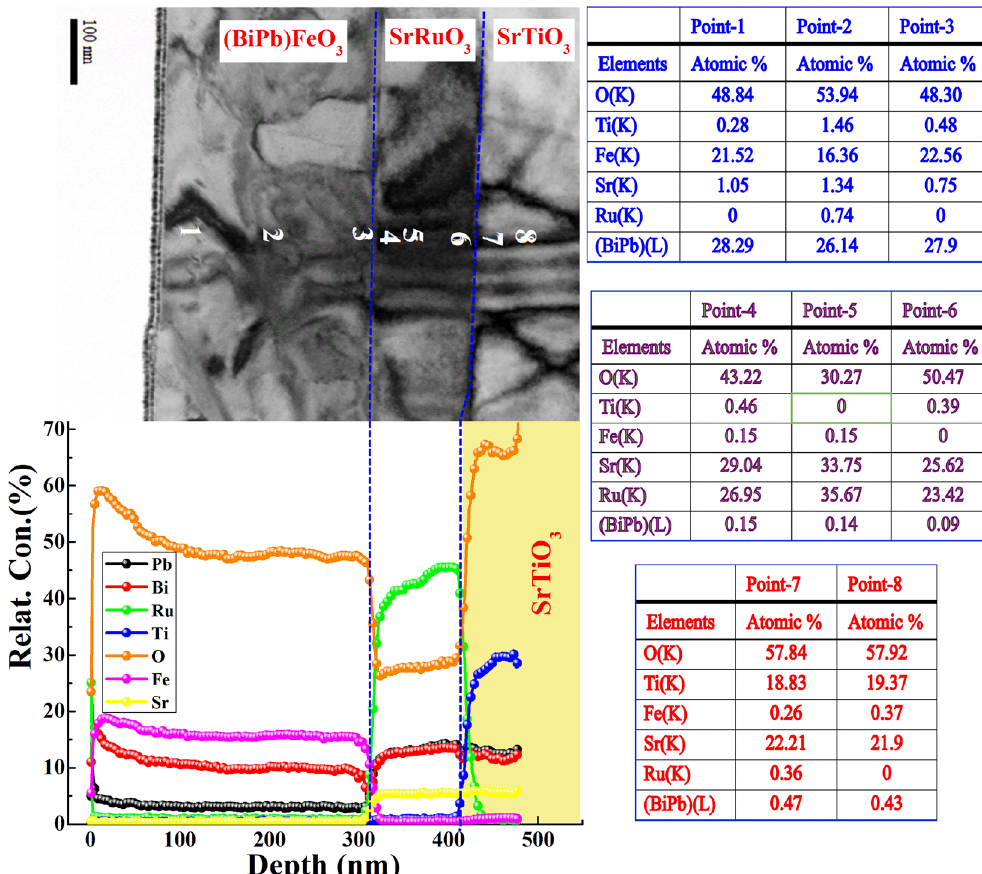
Figure 4. Compositional analysis of (BiPb)FeO 3 /SrRuO 3 /SrTiO 3 heterostructures. Top left: STEM bright field image of (BiPb)FeO 3 /SrRuO 3 /SrTiO 3 heterostructure with T g = 700 °C, Bottom Left: Auger electron spectroscopy depth profiles with colour assigned to the different elements throughout the (BiPb)FeO 3 /SrRuO 3 and SrRuO 3 /SrTiO 3 interfaces 11 . This gives clear evidence of Bi and Pb inter-diffusion. Right: TEM EDS analysis across the points 1 to 8 shown on the bright field